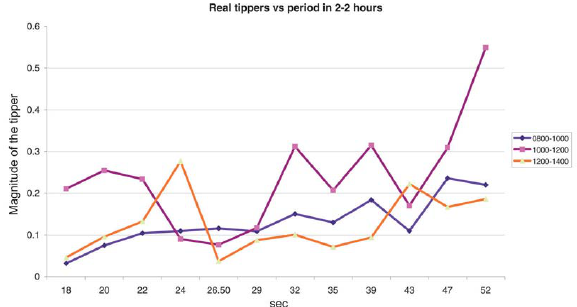
Fig. 7. NCK real tippers vs. period in 2-hour sections (periods 18-52 s).